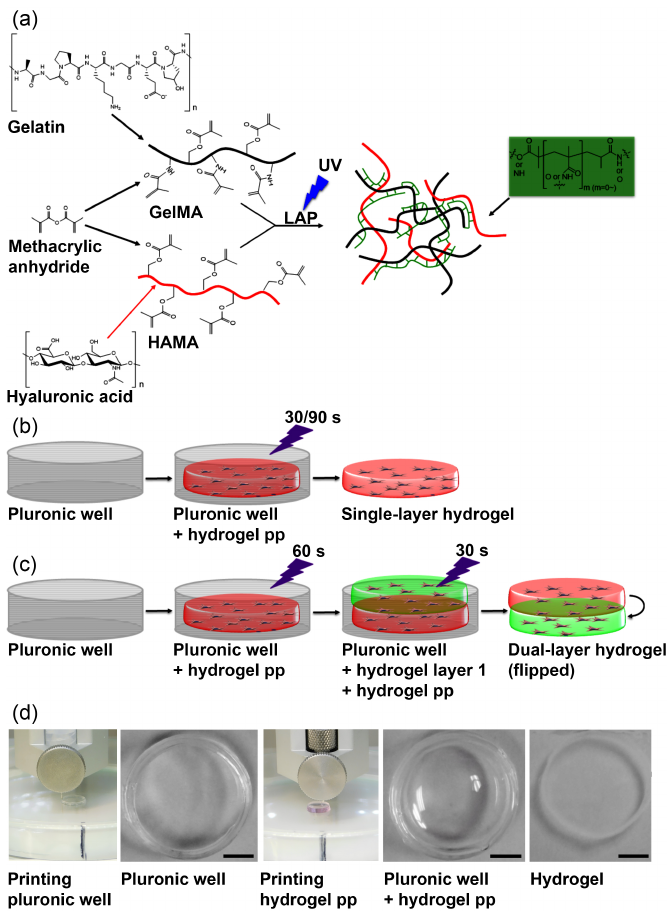
Figure 2. Bioprinting of hybrid hydrogel constructs using methacrylated gelatin (GelMA) and methacrylated hyaluronic acid (HAMA): ( a ) Schematic of hybrid GelMA/HAMA hydrogel synthesis and gelation. Black = gelatin, Red = hyaluronic acid, green = crosslinks, UV = photocrosslinking with 365 nm UV light at 2.5 mW/cm 2 ; ( b , c ) 3D printing of single- and dual-layer hydrogel constructs by printing a Pluronic ring, followed by hydrogel pre-polymer (pp) inside, and photocrosslinking for a total of 30 and/or 90 s per layer; ( d ) Representative images of (left to right): 3D bioprinting the